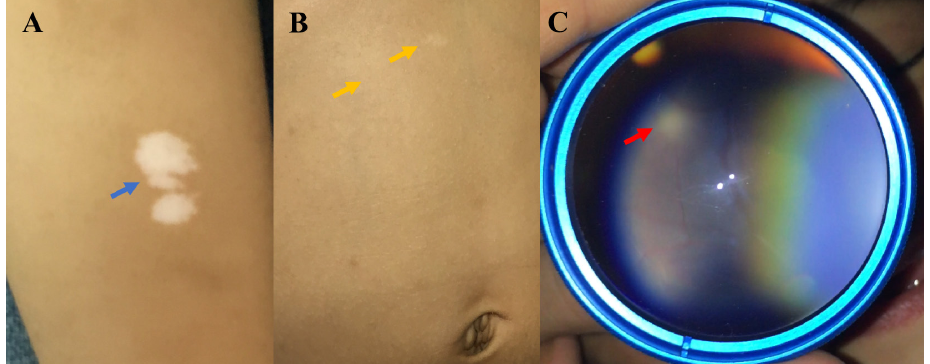
Figure 1: A) Hypopigmented macules on lower leg (blue arrow). B) Confetti skin lesions (yellow arrow). C) Retinal Hamartoma superior to disc in her rigth eye (red arrow).